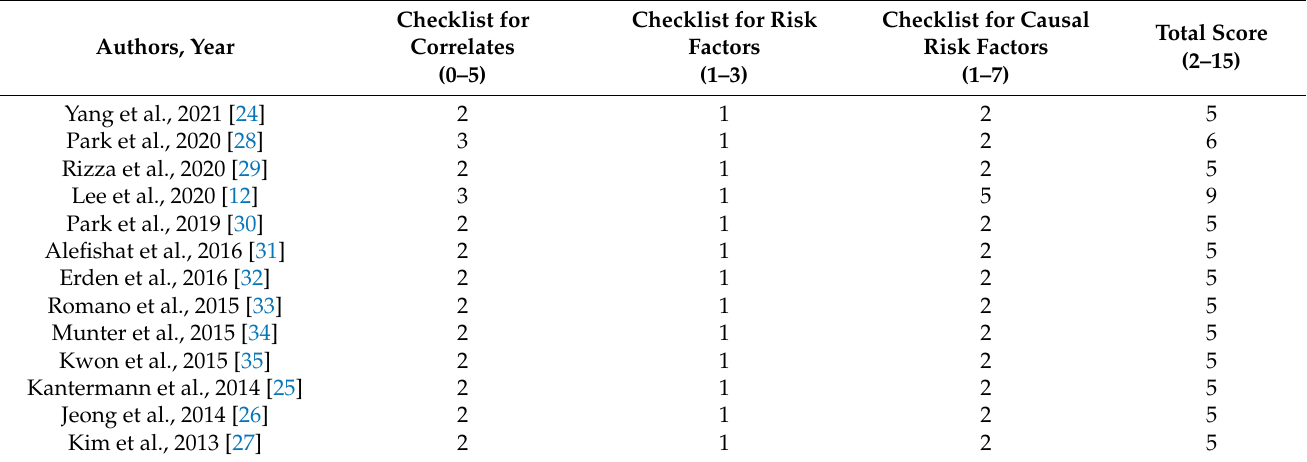
Table 3. Scoring of Cambridge Quality Checklists on included studies.